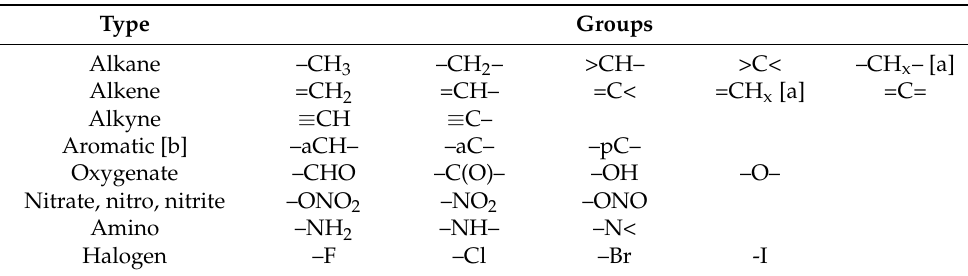
Table 1. List of groups contained in organic reactants that are used as a basis of the structure–reactivity estimates in this work.